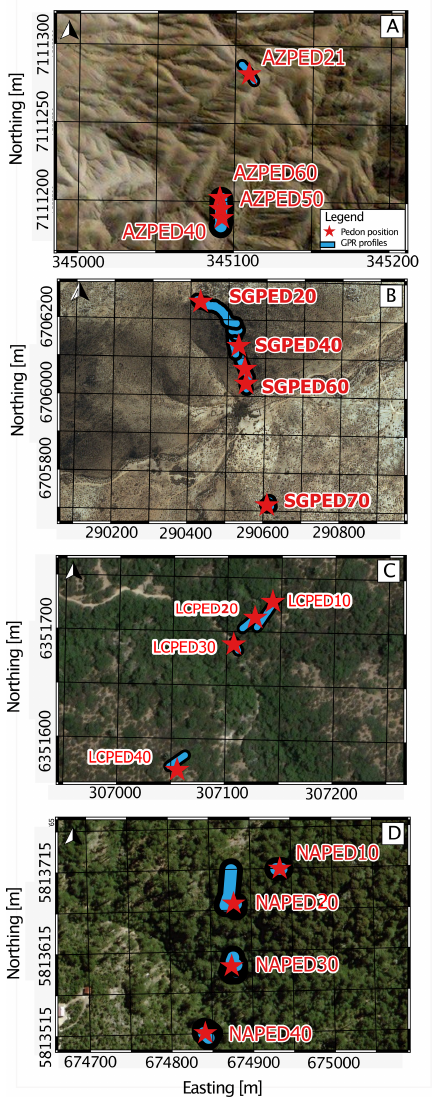
Figure 2. Satellite images (data source: Google Earth©) of the four study areas from north to south in latitude: (a) Pan de Azú- car, (b) Santa Gracia, (c) La Campana, and (d) Nahuelbuta. Red stars indicate the pedon positions, whereas the blue lines represent the locations of the geophysical